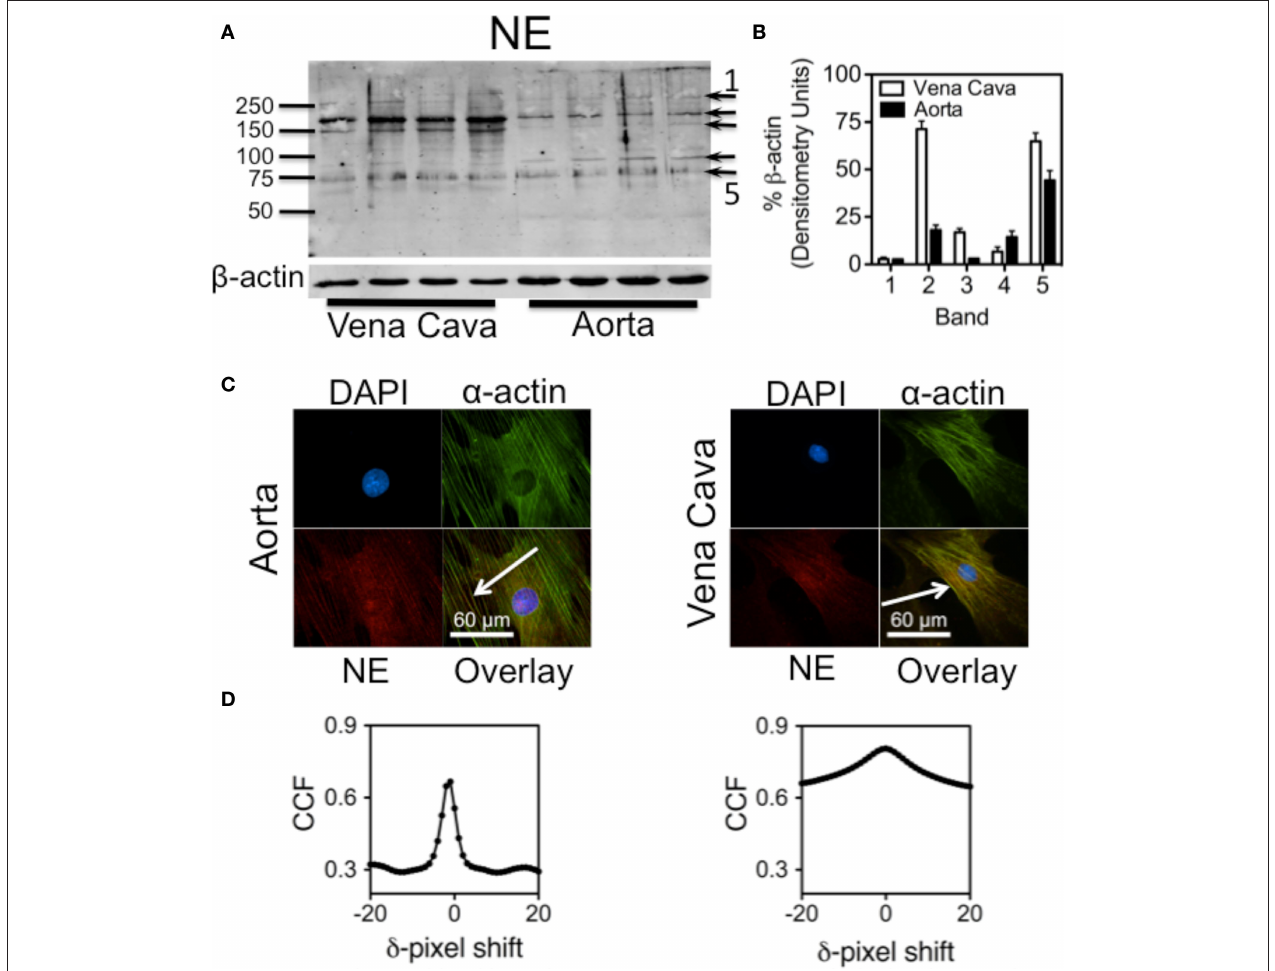
Figure 3 | Proteins amidated by endogenous Ne. (A) Western analysis showing proteins recognized by an anti-NE-BSA antibody in rat aorta and vena cava homogenates not exposed to exogenous NE. (B) Densitometry of the five darkest bands, (arrows in A ) from the Western analysis. Each band was normalized to β -actin. (C) Images of cultured smooth muscle cells from rat aorta (left) and vena cava (right). Cells were stained for nuclei (DAPI, blue, top left), α -actin (green, top right) and NE